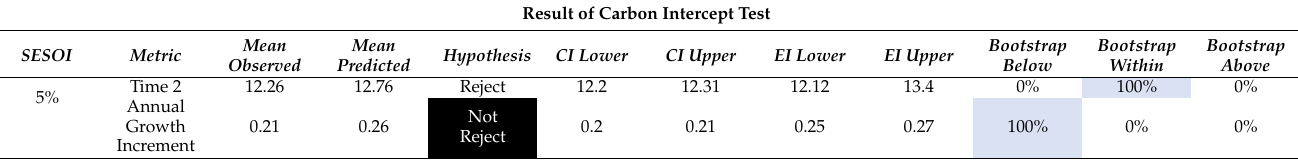
Table 3. Equivalence test outcomes for intercept and slope for Time 2 (stand-level above-ground, live-tree, non-foliar carbon stocks) predicted ~10 years forward and Annual Growth in those stocks at 5, 10, and 25% smallest effect size of interest (SESOI). Blackened boxes indicate tests that failed to reject the null hypothesis of